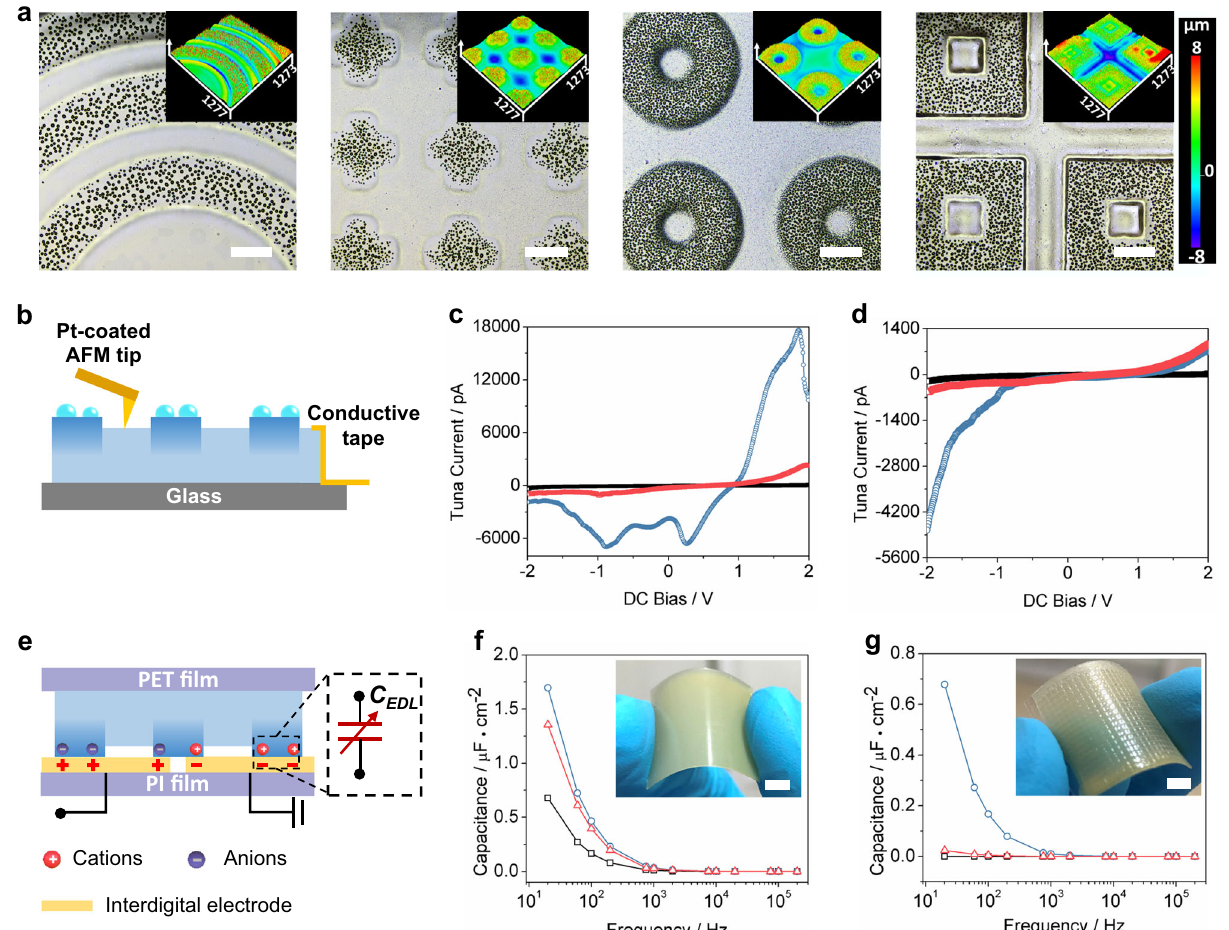
Fig. 3 | Localized regulation of the ionic electrical performance of primary patterns.a Microscopy images showing IL droplets @ primarypatterns, scalebar: 200 μ m. b Schematic diagram of the conductivity AFM measurement (C-AFM) for IL droplets @primary patterns. Averaged point contact I-V curve obtained after averagingI-Vresponsesfrom15differentspotsshownfor c unexposedregions(i.e., pristineiontronichost)and d exposedregions(i.e.,ILdroplets@primarypatterns) withmolarratiosofAn-PILtoILwere1:1(blackline),1:2(gray-blueline),and1:3(red line), respectively. e Schematic diagram of the EDL capacitance between